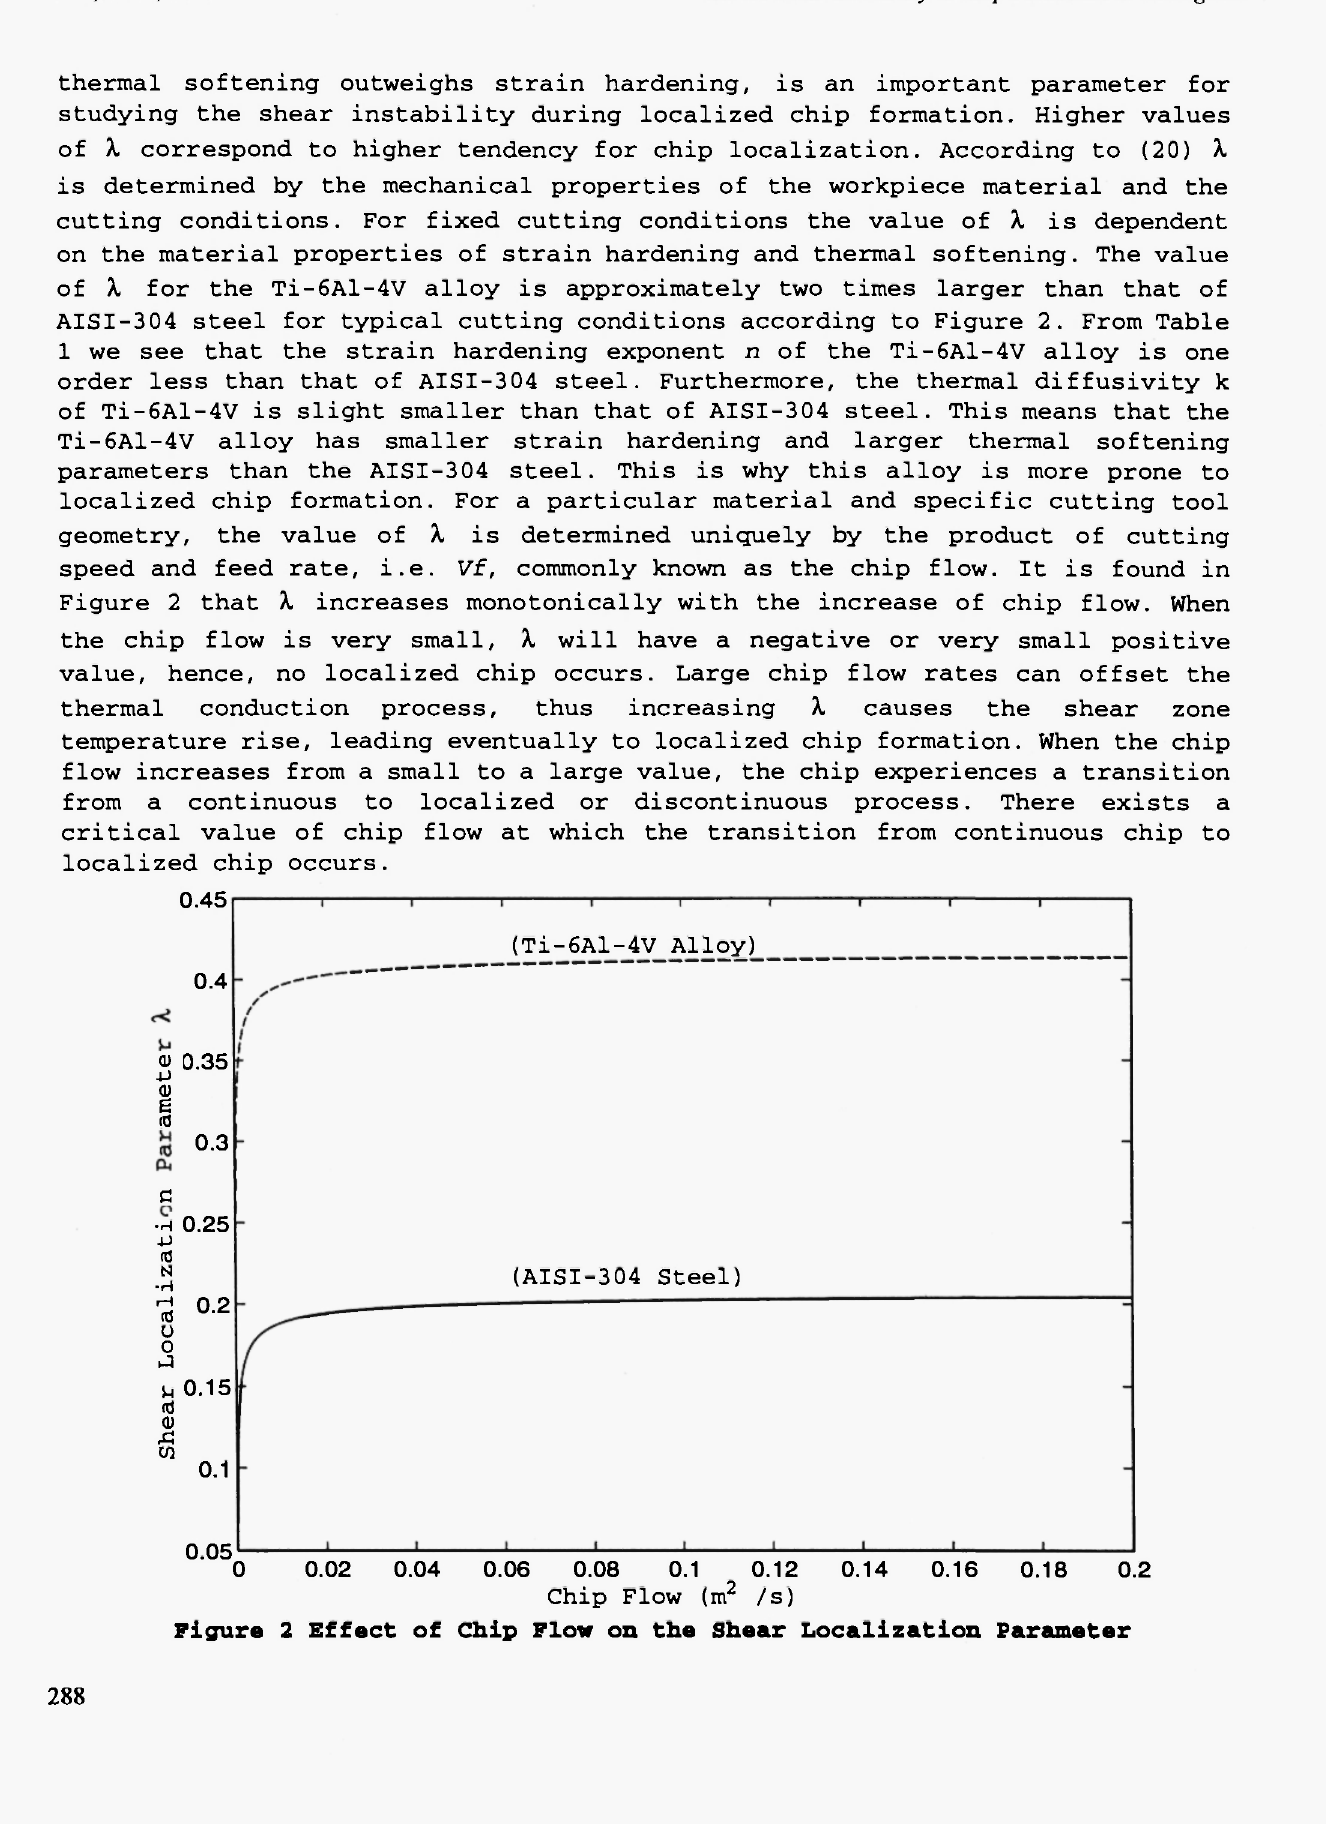
Figure 2 Effect of Chip Flow on the Shear Localization Parameter